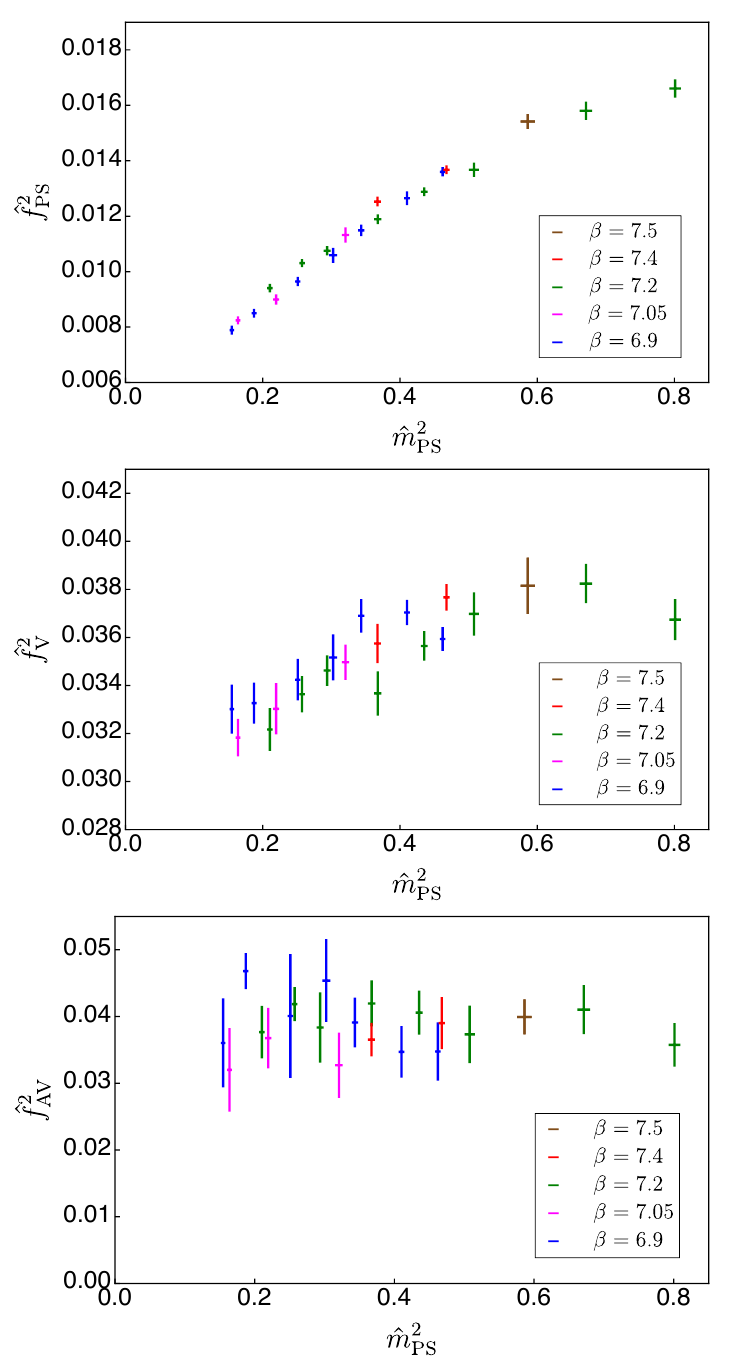
Figure 7. Decay constant squared for pseudoscalar (PS, top), vector (V, middle) and axial-vector (AV, bottom) mesons as a function of the pseudoscalar mass squared ^ m 2 to di(cid:11)erent lattice couplings as shown in the legends. The error bars represent the size of statistical uncertainties. (See appendix A.3 for the details.)